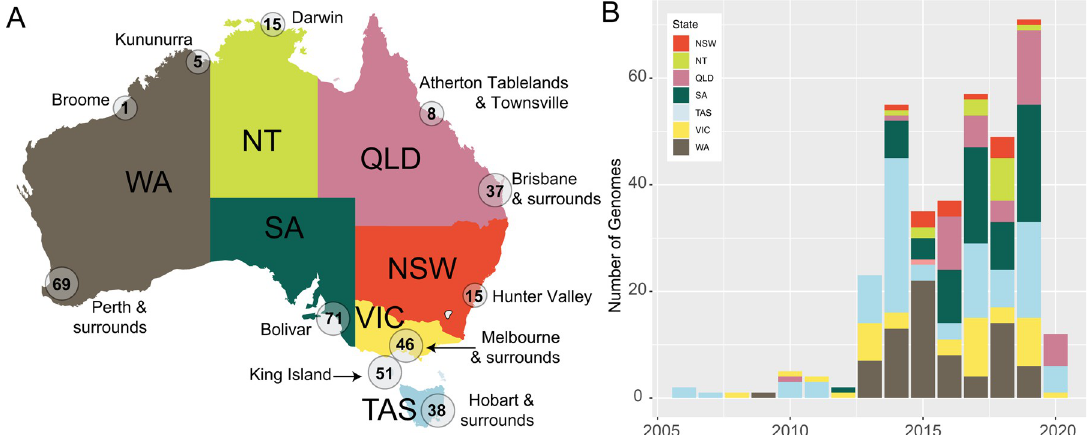
Fig 1. Spatial and temporal distribution of avian influenza genomes used in this study. (A) Map of Australia illustrating regional sampling locations. Where sampling locations were within 500km, they were merged into a single location. The value within the circle corresponds to the number of unique viral genomes comprising at least one segment from each location. States and Territories are as follows: VIC Victoria, NSW New South Wales, QLD Queensland, NT Northern Territory, WA Western Australia, SA South Australia and TAS Tasmania. Map shapefile from mapsvg, distributed under a CC BY 4.0 licence. https://mapsvg.com/maps/australia (B) Number of genomes per state per year. Colours from panel B correspond to the fill colour of the state in panel A. This figure includes genomes comprising one or more segments and contains no duplicates. This figure includes all sequences generated as part of the National Avian Influenza Wild Bird Surveillance Program, including those recently published in [40,41].Further metadata is available in S1 Table and S2 and S3